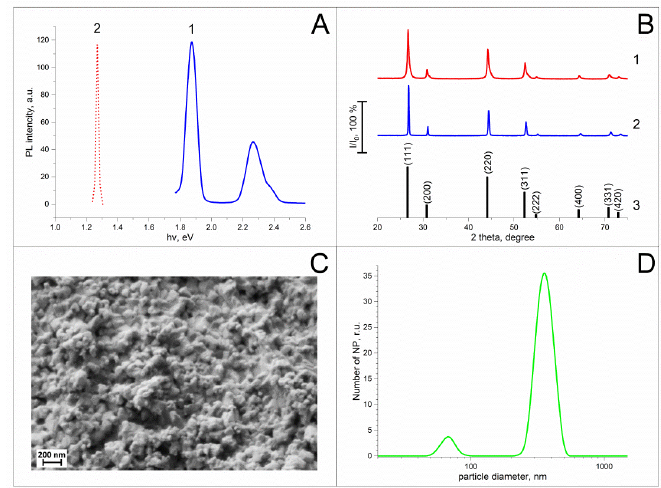
Figure 1. Characteristics of nanosized fluorophores (Sr 0.910 Yb 0.075 Er 0.015 F 2.090 ). ( A ) Photoluminescence of the nanoparticles in acetone in the PAR range (1), which were excited with a semiconductor laser Formatted: English (United States)